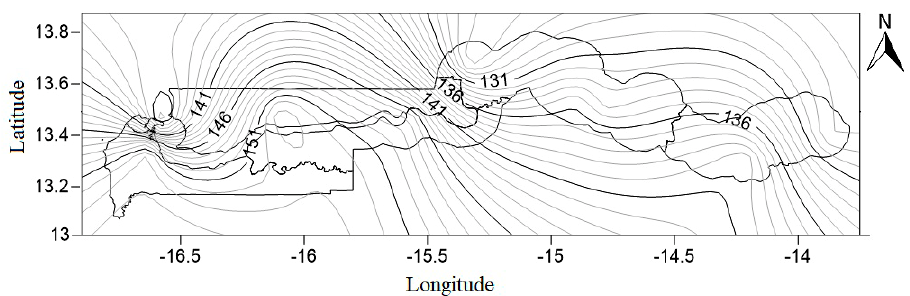
Figure 2. Mean seasonal rainfall (mm) distribution over The Gambia